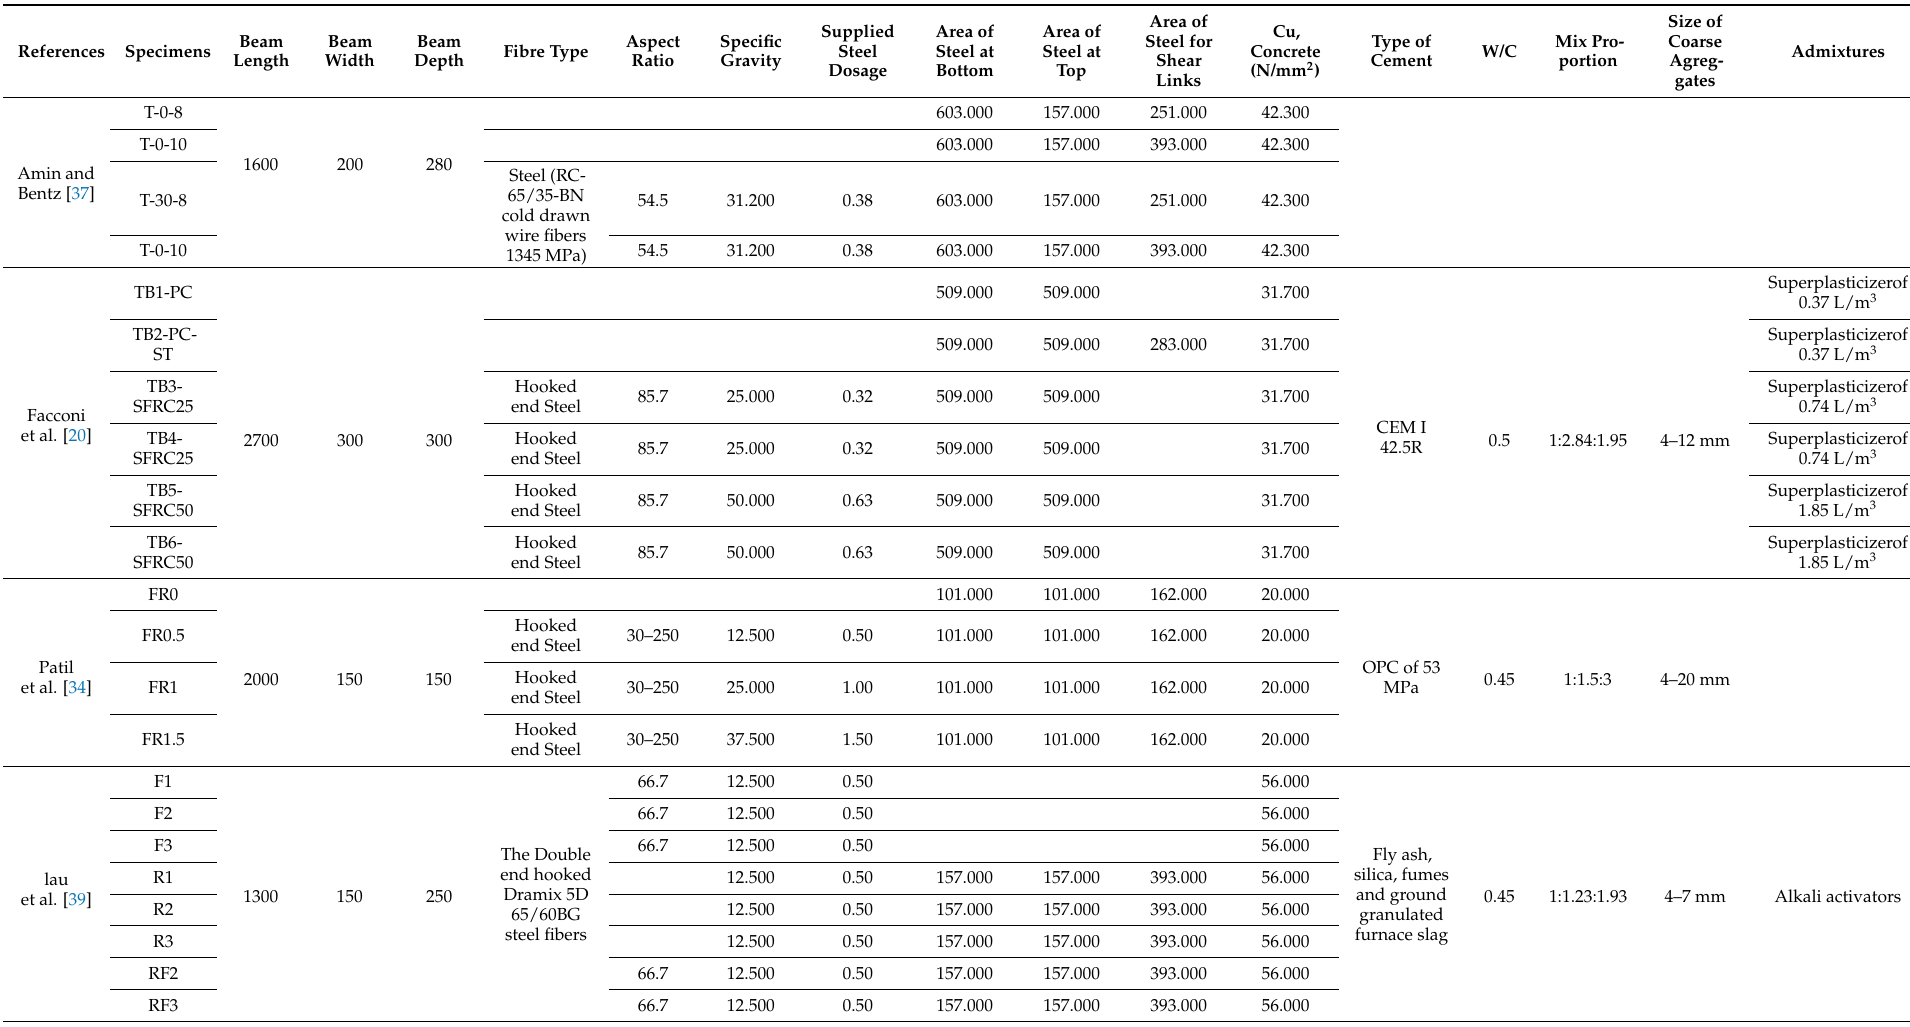
Table 1. Methods of preparation of steel fibre reinforced concrete from previous